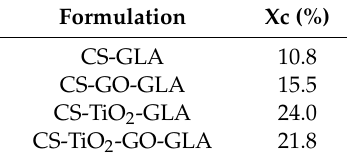
Table 1. The crystallinity index (Xc) of the different formulations calculated from the XRD analysis. Formulation